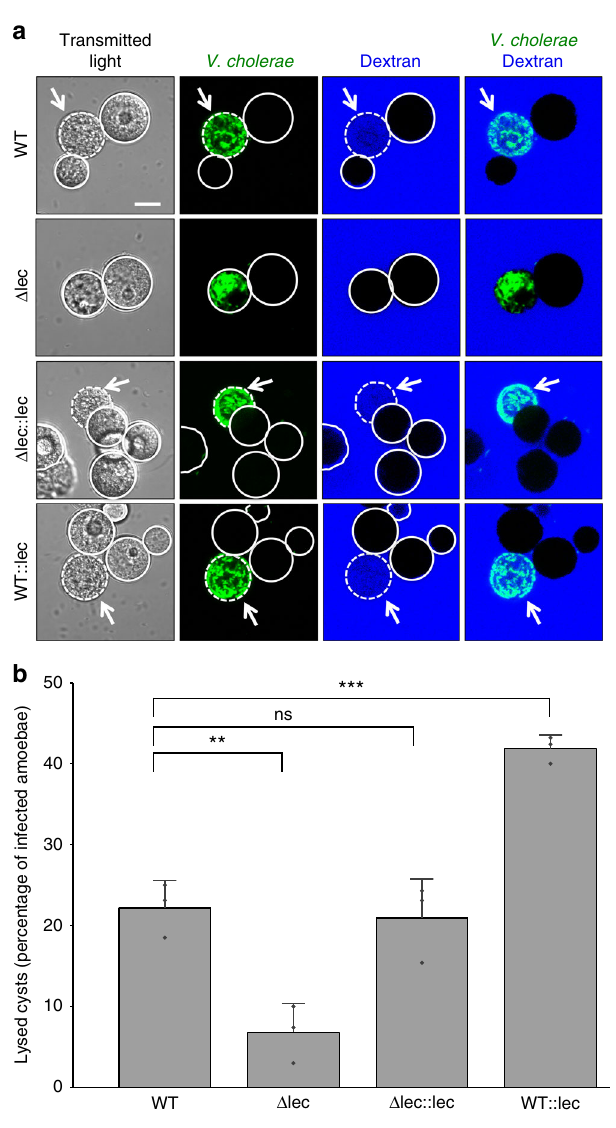
Fig. 5 Cyst permeabilization by V. cholerae depends on its lecithinase. a Representative images and b quanti fi cation of lysed or non-lysed cysts that were infected by WT, lecithinase-minus ( Δ lec), lecithinase-minus but complemented ( Δ lec::lec), and lec- merodiploid V. cholerae strains (all GFP positive). The permeabilization phenotype was visualized through the in fi ltration of dextran from the surrounding medium in the white arrow- marked cysts, which did not occur for the Δ lec strain. Scale bar: 10 µ m. The graph in b represents average values from three independent biological replicates (±s.d.). Statistics are based on a one-way ANOVA with *** p ≤ 0.001; ** p ≤ 0.01; ns, p >